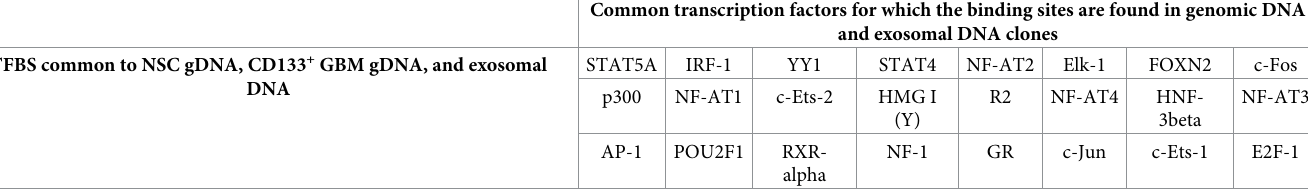
Table 4. Summary of common TFBs found in the upstream of NANOGP8 isolated from the gDNA and exosomal DNA clones. Common transcription factors for which the binding sites are found in genomic DNA and exosomal DNA clones